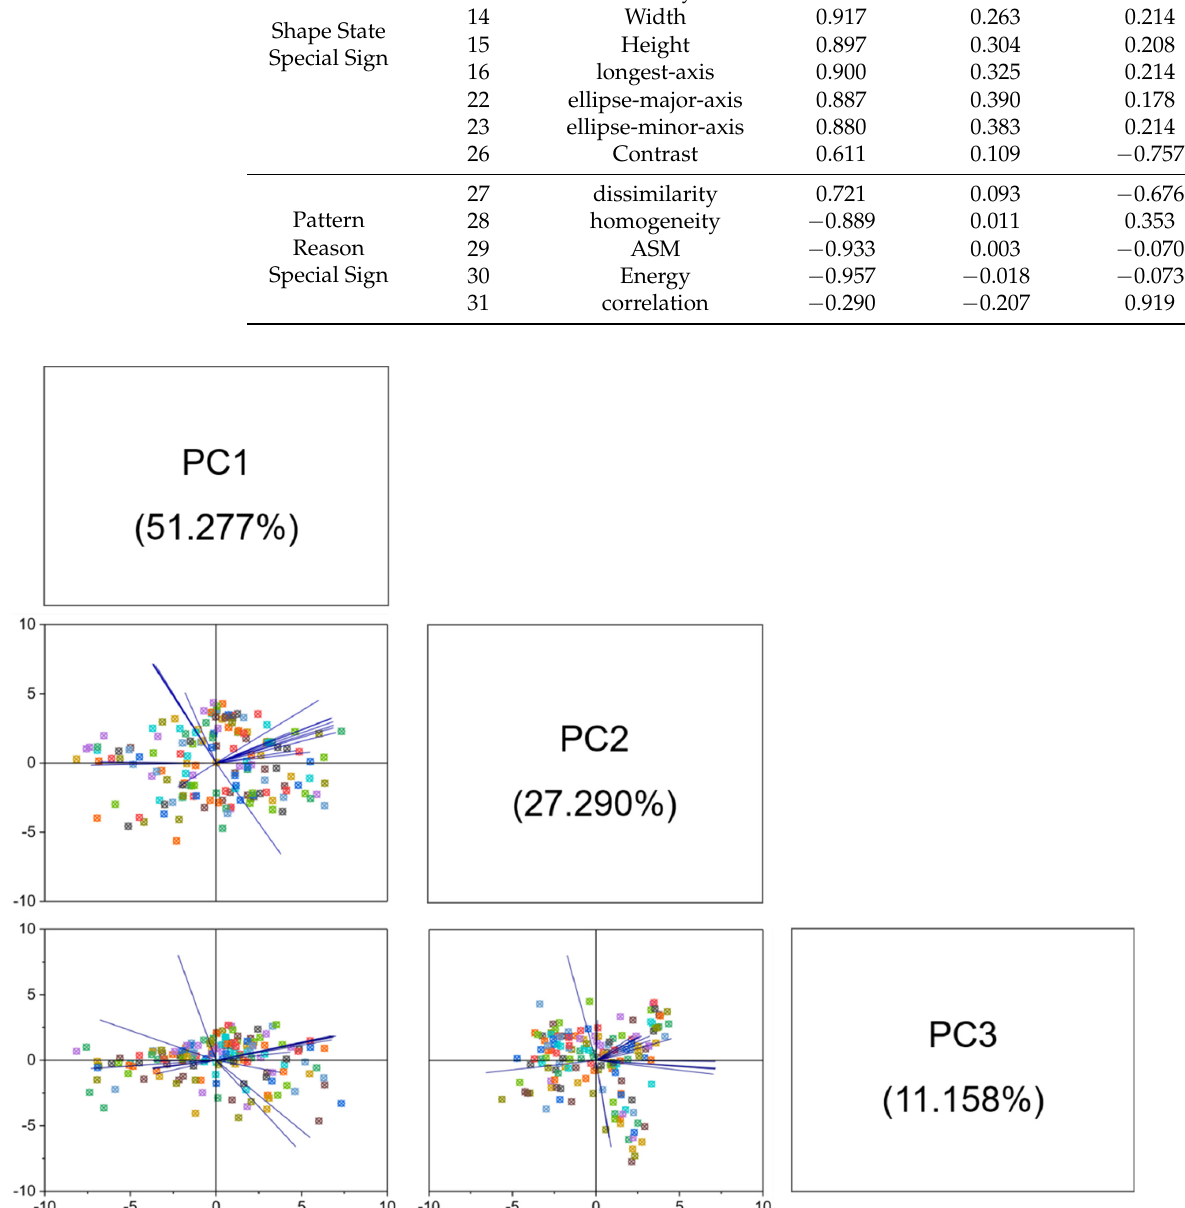
Figure 7. Scatter plots showing projections of the top 3 PCs based on PCA of image-based data. Note: Component scores (shown in points) are shown with different colors with same shape according to the phenotypical features. Component loading vectors (represented in lines) of all features were superimposed proportionally to their contribution.